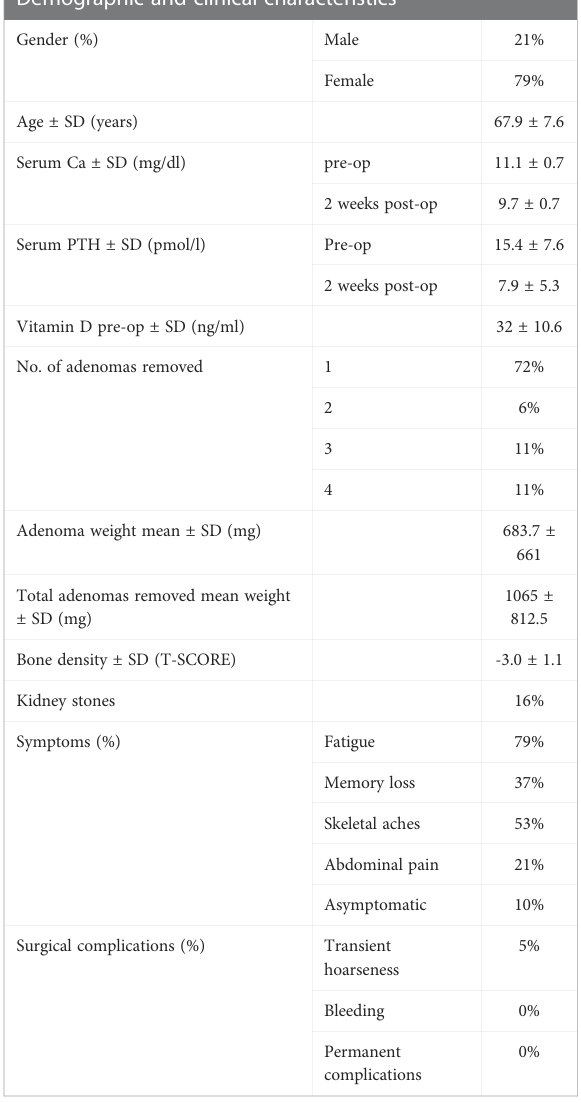
TABLE 1 Demographic and clinical characteristics. Demographic and clinical